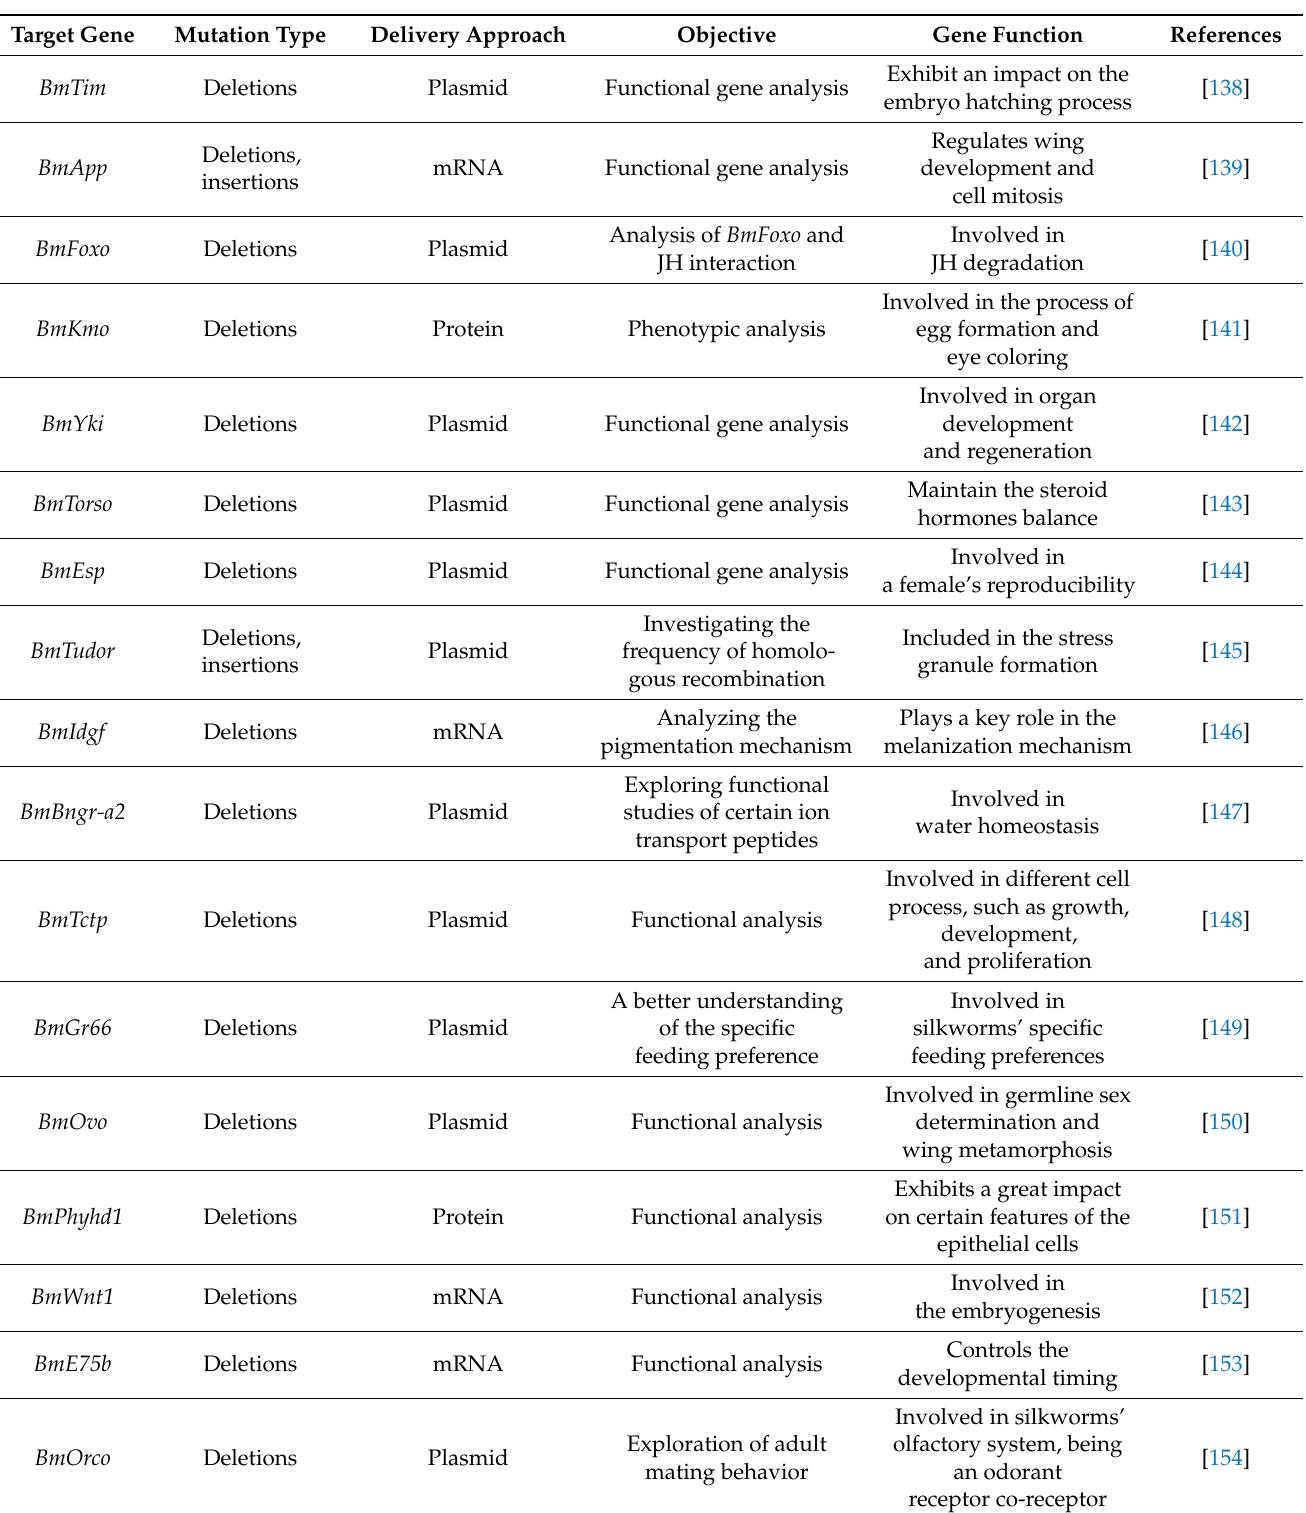
Table 3. CRISPR-Cas applications in B. mori